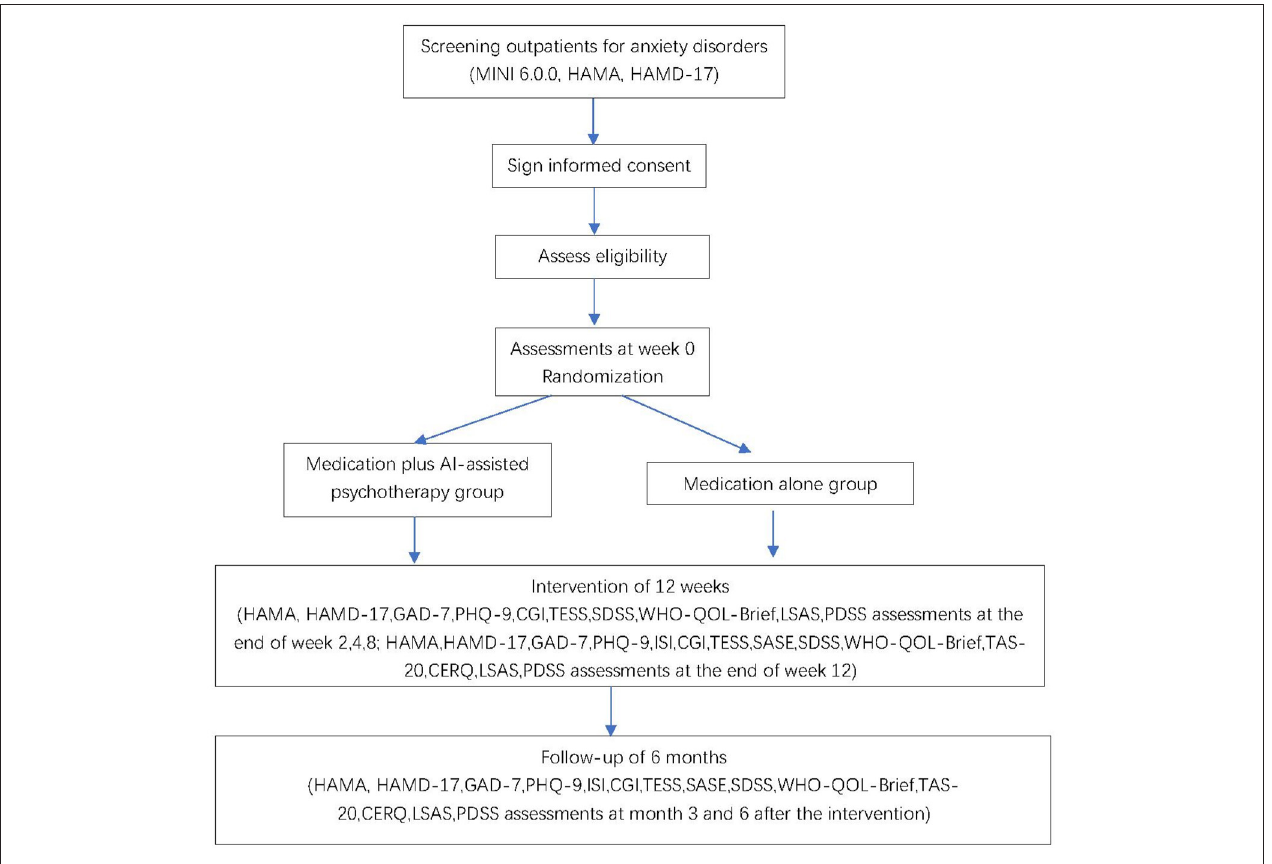
FIGURE 1 | Study design and measurement time